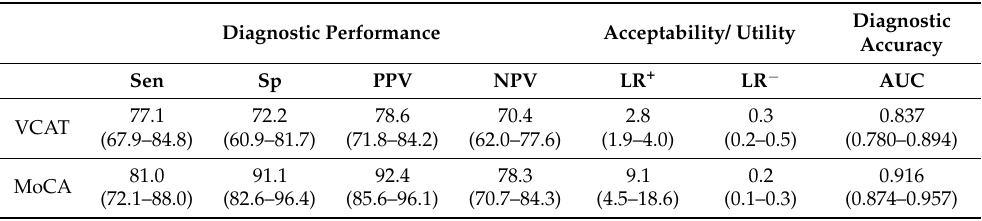
Table 4. Overall diagnostic performance, clinical acceptance/ utility and diagnostic accuracy of VCAT and MoCA for CI and CHP.